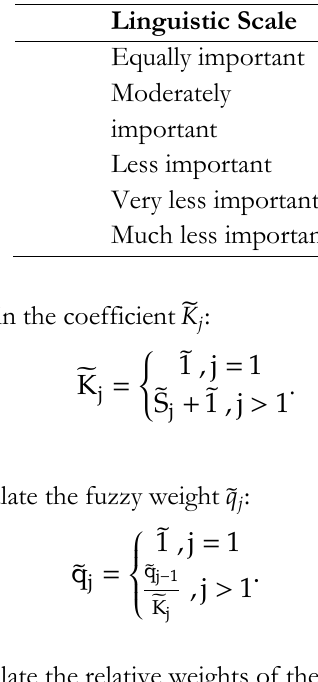
Table 2. Linguistic comparison scale and fuzzy values